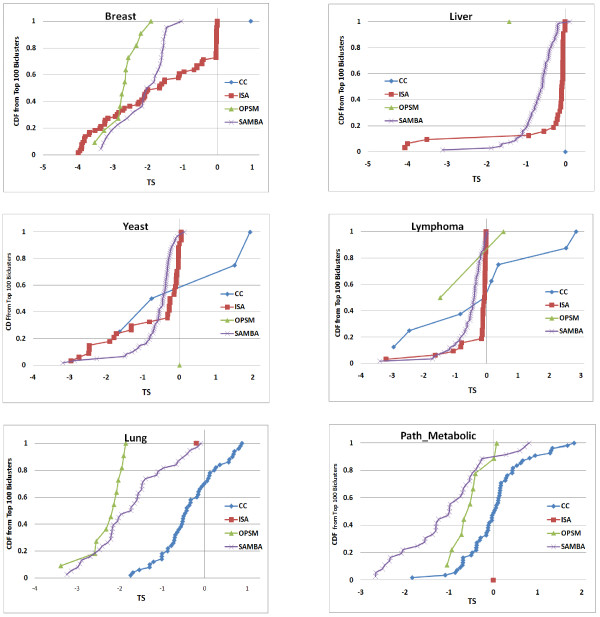
Stratification of top 100 biclusters. Cumulative distribution TS1(b) of the biclusters from each algorithm on 6 datasets contributing to the top100 biclusters from combined ranking. TS1(b) < -1 shows B-type co-expression, TS1(b) > 1 shows T-type co-expression and -1 < TS1(b) <1 indicates μ-type co-expression.